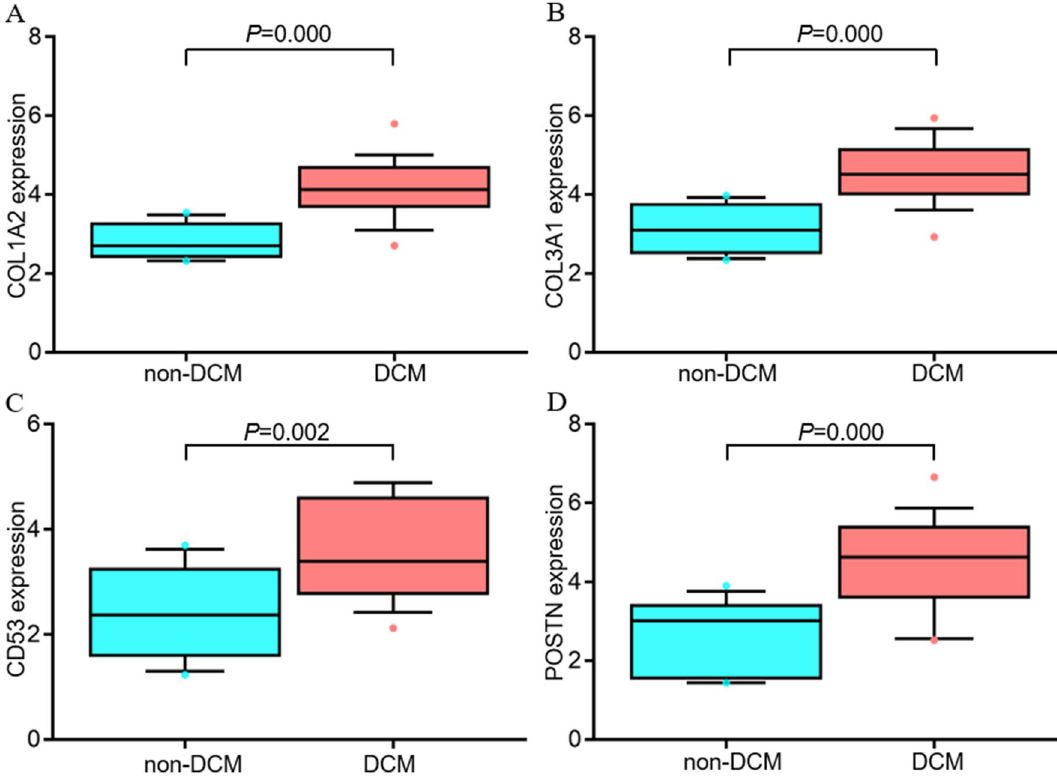
Figure 7. The expression levels of potential immune-related genes in DCM. ( A ) The expression level of COL1A2 , ( B ) The expression level of COL3A1 , ( C ) The expression level of CD53 , and ( D ) The expression level of POSTN . DCM: dilated